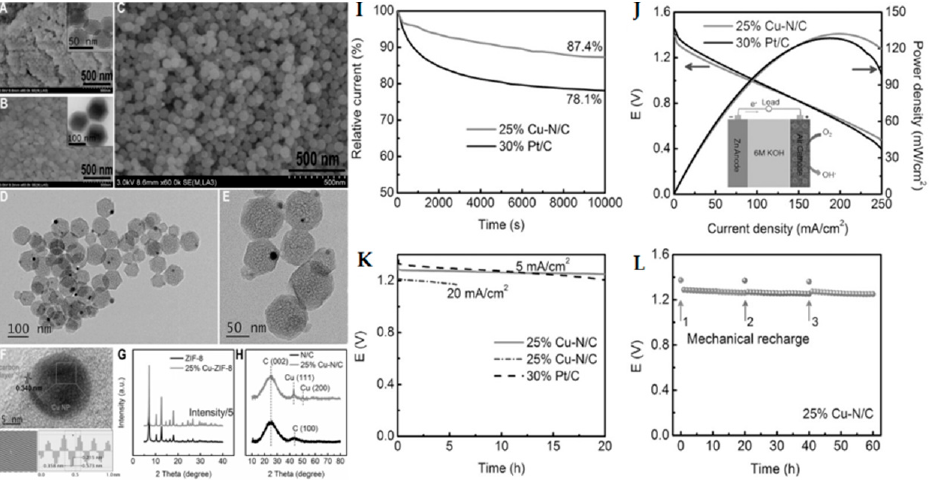
Figure 9. SEM images of ( A ) ZIF-8, ( B ) 25% Cu-ZIF-8, and ( C ) 25% Cu-N/C (inset in ( A , B ) corresponds with TEM image); ( D – F ) TEM images of 25% Cu-N/C. XRD patterns of ( G ) ZIF-8 and 25% Cu-ZIF-8, and ( H ) N/C and 25% Cu-N/C; ( I ) Normalized current–time responses of the ORR on 25% Cu-N/C, and 30 wt% Pt/C in O 2 -saturated 0.1 M KOH solution; ( J ) Polarization and power density curves of a Zn–air battery with 25% Cu-N/C and 30 wt% Pt/C as cathode catalysts, respectively (inset: scheme of the Zn–air battery); ( K ) Discharge curves of a Zn–air battery assembled from 25% Cu-N/C and 30 wt% Pt/C catalysts at a current density of 5 and 20 mA cm − 2 ; ( L ) “Mechanical recharging” the Zn–air battery with 25% Cu-N/C as cathode catalyst at 5 mA cm − 2 by replenishing the Zn anode and electrolyte. Copyright 2017 Wiley-VCH Verlag GmbH & Co. KGaA, Weinheim [99]. Table 1. Summary of ORR/OER performance of MOF-based non-precious metal catalysts.